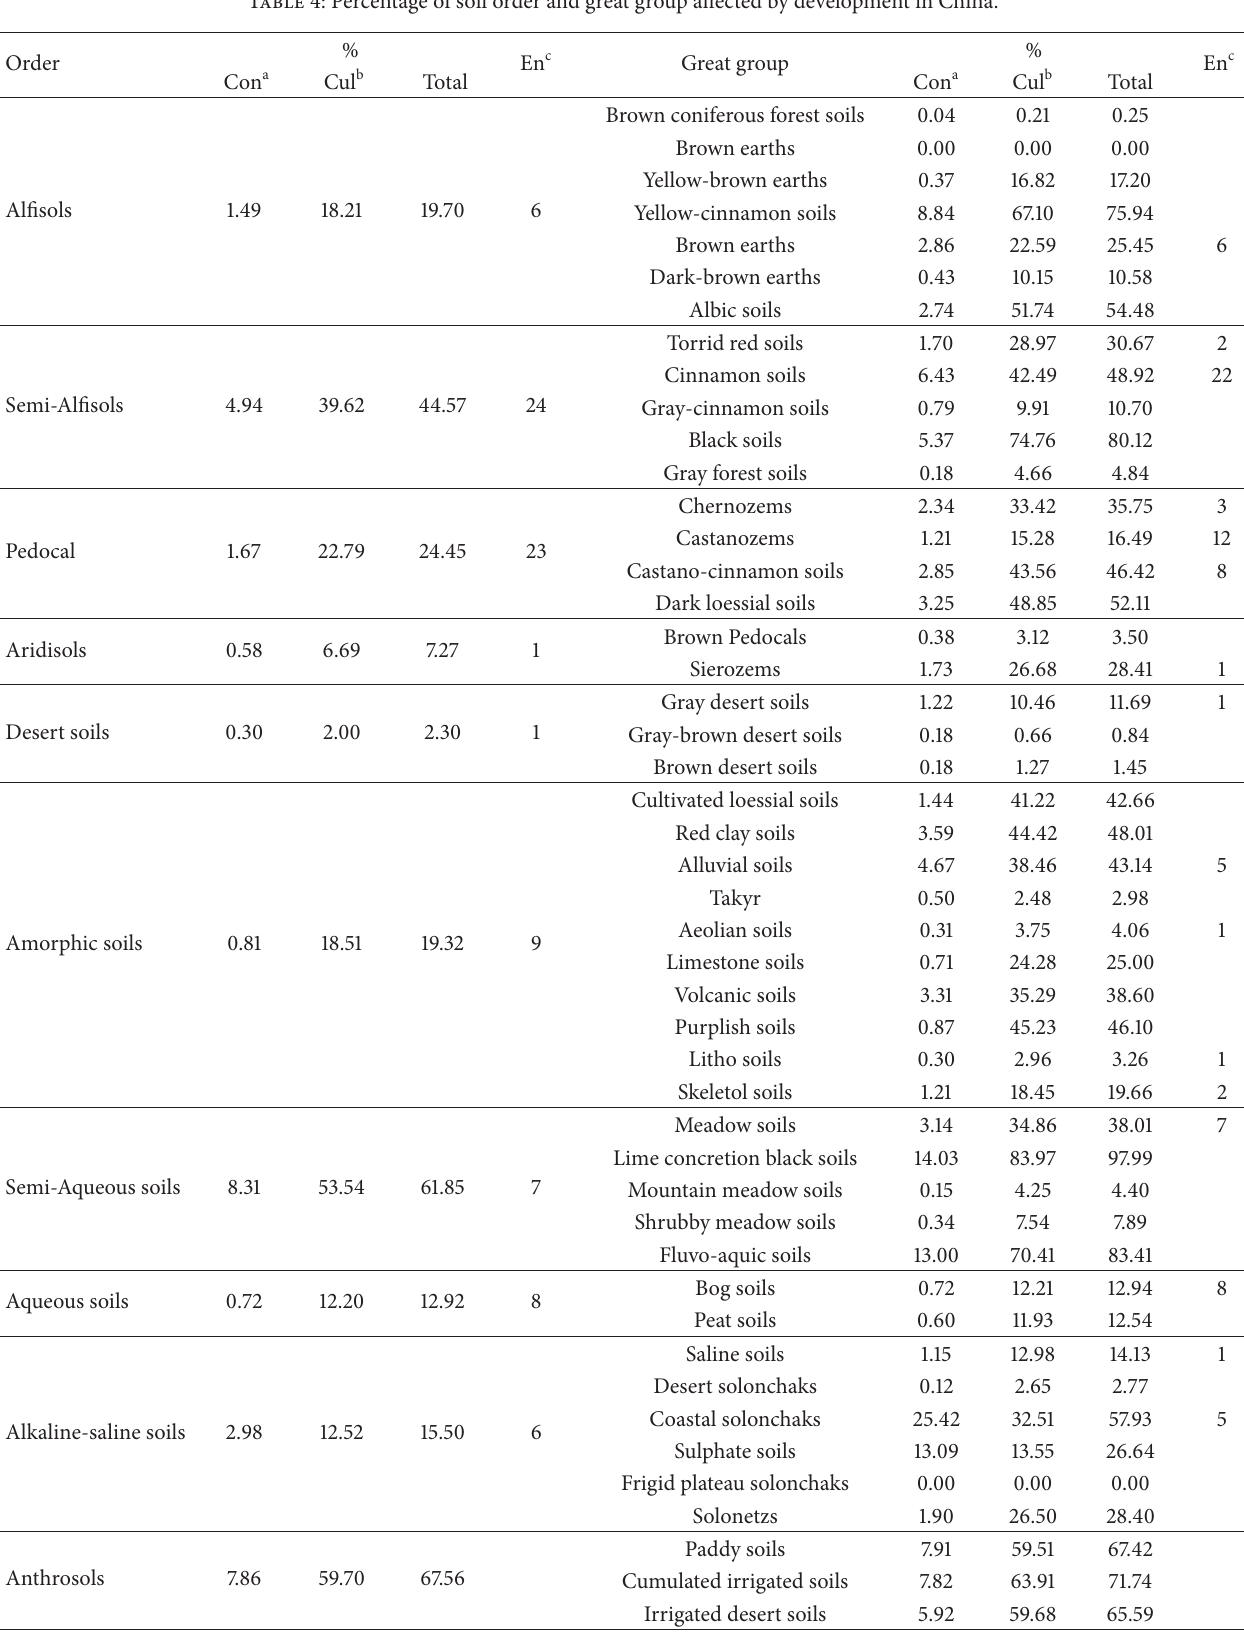
Table 4: Percentage of soil order and great group affected by development in